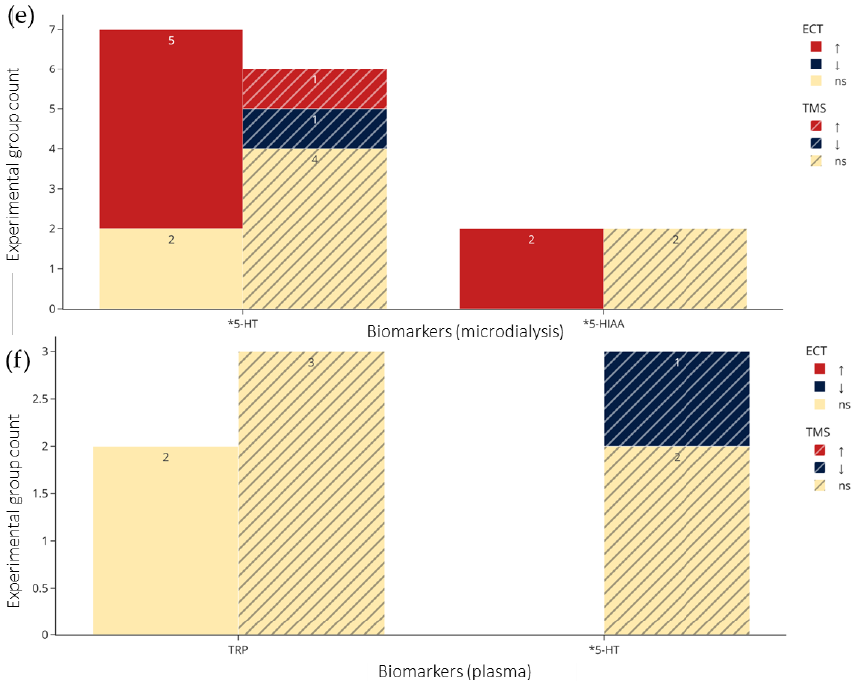
Figure 5. Count of experimental groups reporting significant increases, decreases, or non-significant changes in the metabolites by NIBS. ( a – c ) From CSF, plasma, and serum in clinical studies respectively. ( d – f ) from brain tissue, microdialysis, and plasma in preclinical studies respectively. Colors indicate statistical effects on biomarkers by NIBS: red = significant increase; blue = significant decrease; yellow = no significant changes to biomarker levels following NIBS. *: biomarkers in the serotonin pathway; #: biomarkers in the kynurenine pathway. TRP refers to total TRP when not specified, and for brain tissue and microdialysis the regions are collapsed. Abbreviations: TRP: tryptophan; 5-HT: serotonin; 5-HIAA: 5-hydroxyindoleacetic acid; KYN: kynurenine; KA: kynurenic acid; 3-HK: 3-hydroxykynurenine; QA: quinolinic acid; XA: xanthurenic acid; AA: anthranilic acid; PA: picolinic acid; ECT: electroconvulsive therapy; TMS: transcranial magnetic stimulation; ns: not significant.